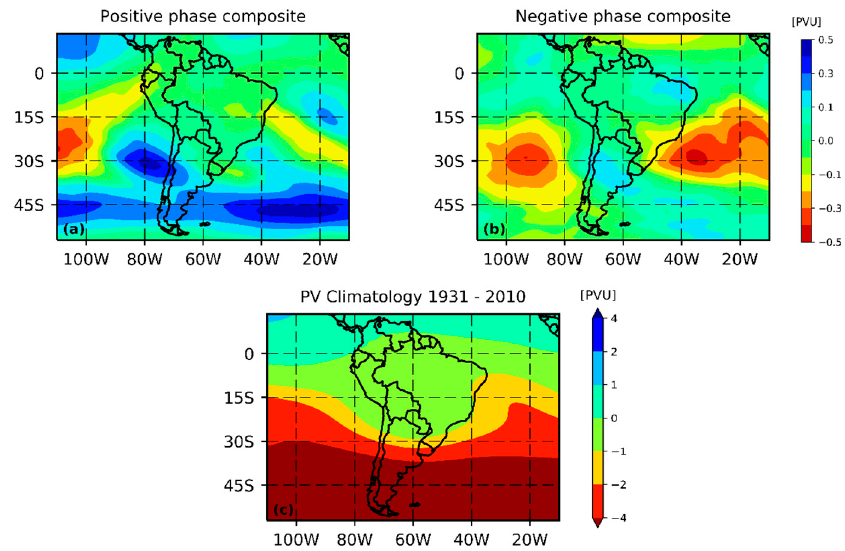
Figure 8. ( a ) DJF Anomalies of potential vorticity corresponding to the composite of the 10 years with the maximum magnitude of PC3; ( b ) As in ( a ) but for the 10 years with the minimum magni- PC3; ( c ) PV Climatology for the 1931–2010 period. Data from ECMWF ERA-20C tude of PC3; ( c ) PV Climatology for the 1931–2010 period. Data from ECMWF ERA-20C reanalysis.